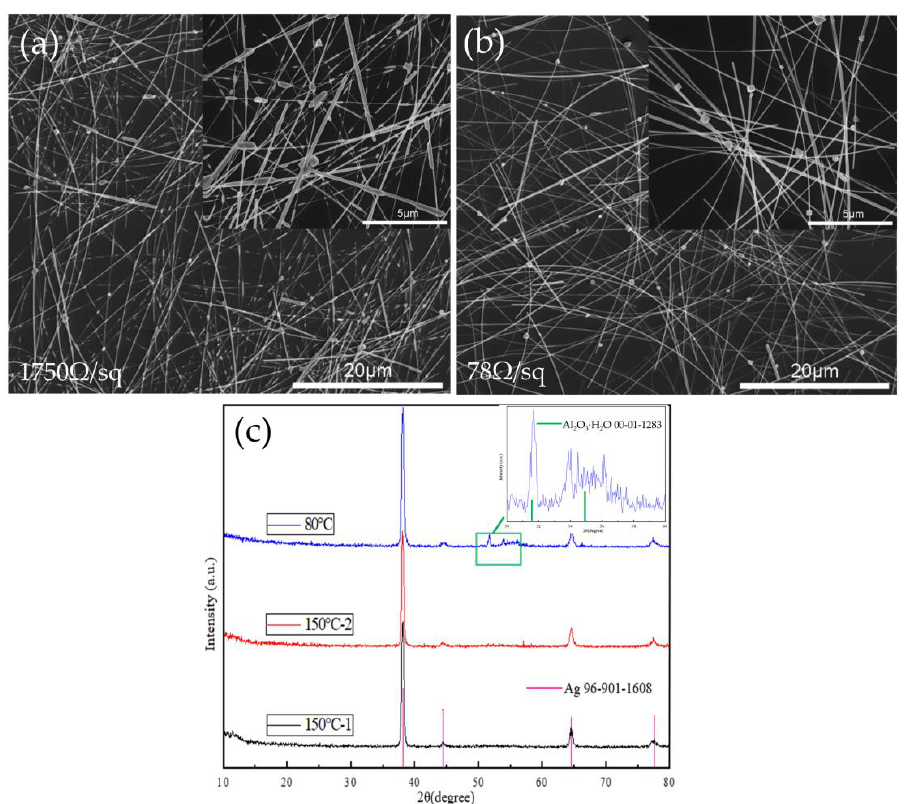
Figure 3. SEM images of AgNW – Al 2 O 3 composite films with different deposition times after heat treatment at 200 °C for 30 min: ( a ) 20 s and ( b ) 40 s. ( c ) XRD pattern of the composite film before and after annealing at 150 °C for 30 min; inset shows the enlarged pattern in the box.